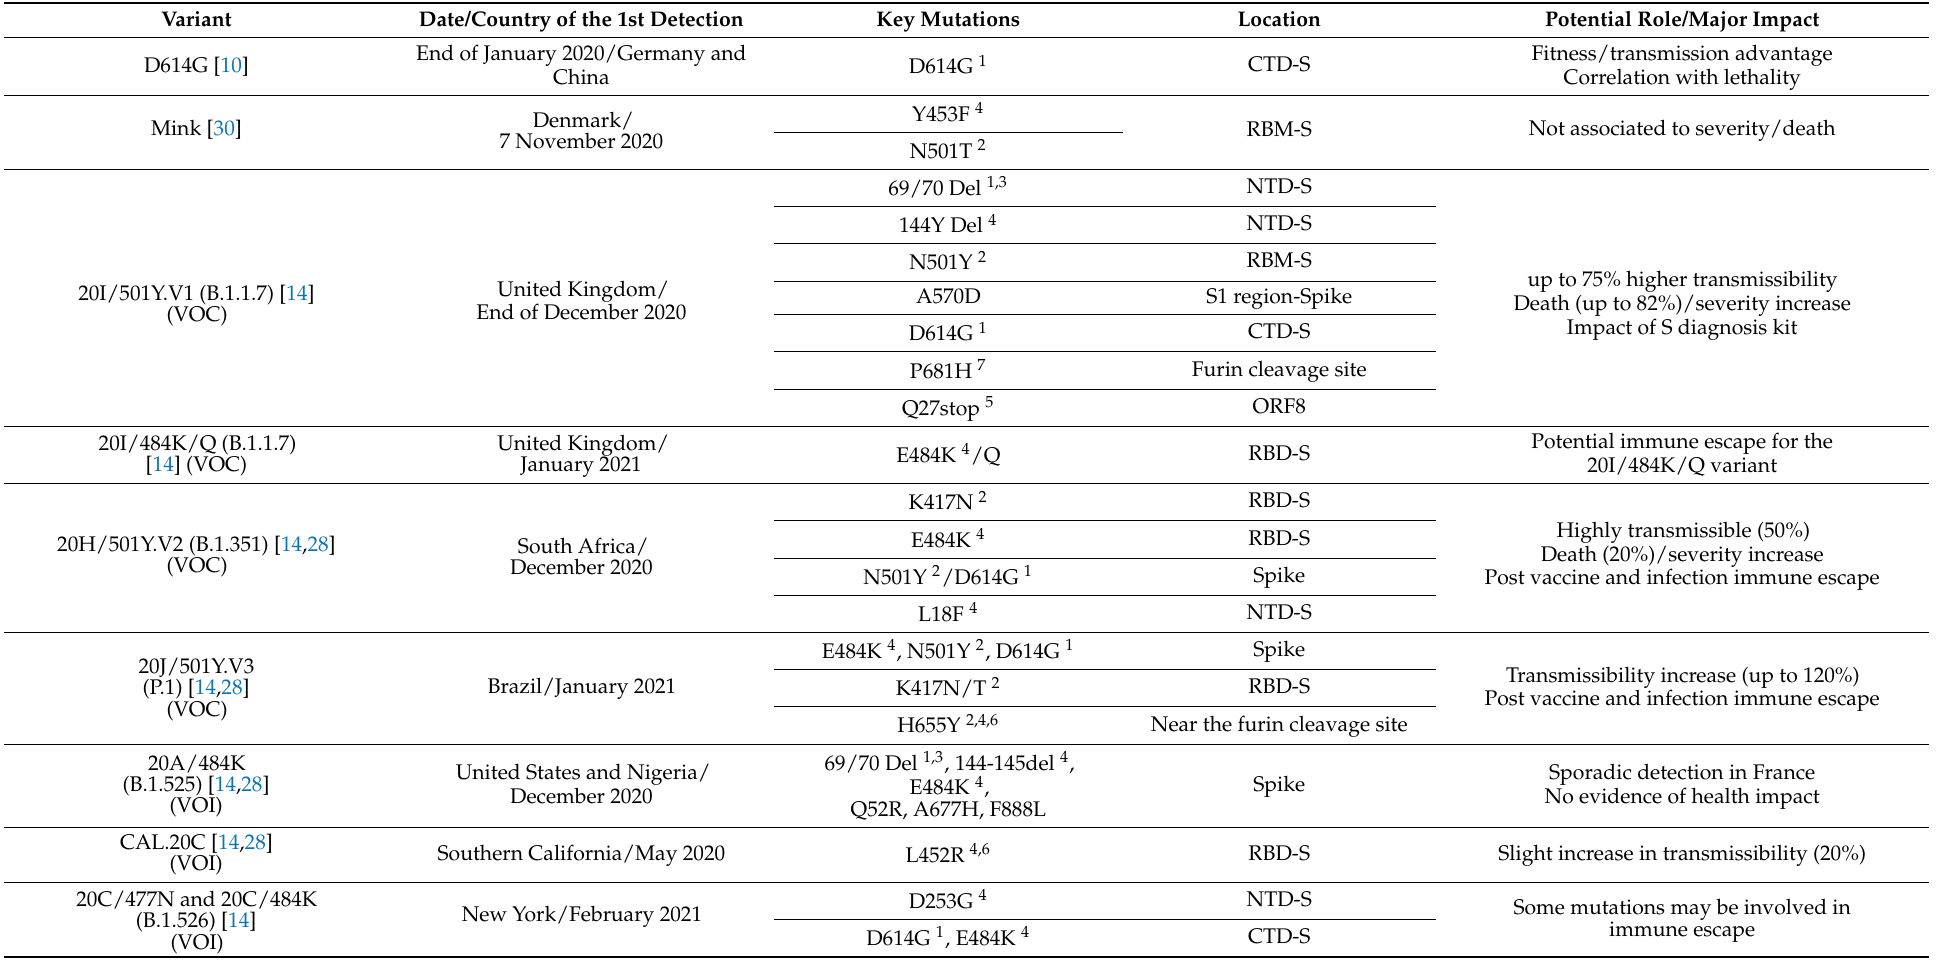
Table 1. SARS-CoV-2 emerging variants of concern and variants of interest in France, and an example of a variant under investigation (according to CNRS and French Health